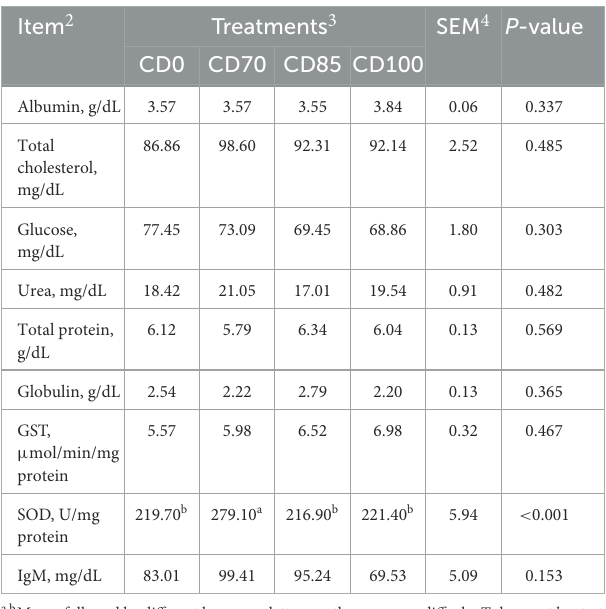
TABLE 3 Effect of β -mannanase supplementation in diets containing xylanase-phytase and reduced metabolizable energy on blood biochemical and immunological profile in finisher pigs on day 52 1 .